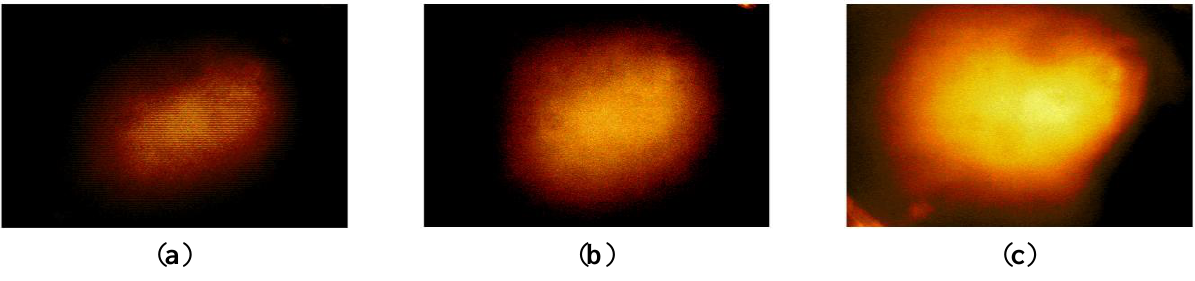
Figure 15. Tactile sensation images of three inclusions embedded in the hardness phantom: ( a ) 44.5 kPa Young’s modulus inclusion, ( b ) 63.5 kPa Young’s modulus inclusion, ( c ) 102.8 kPa Young’s modulus inclusion.